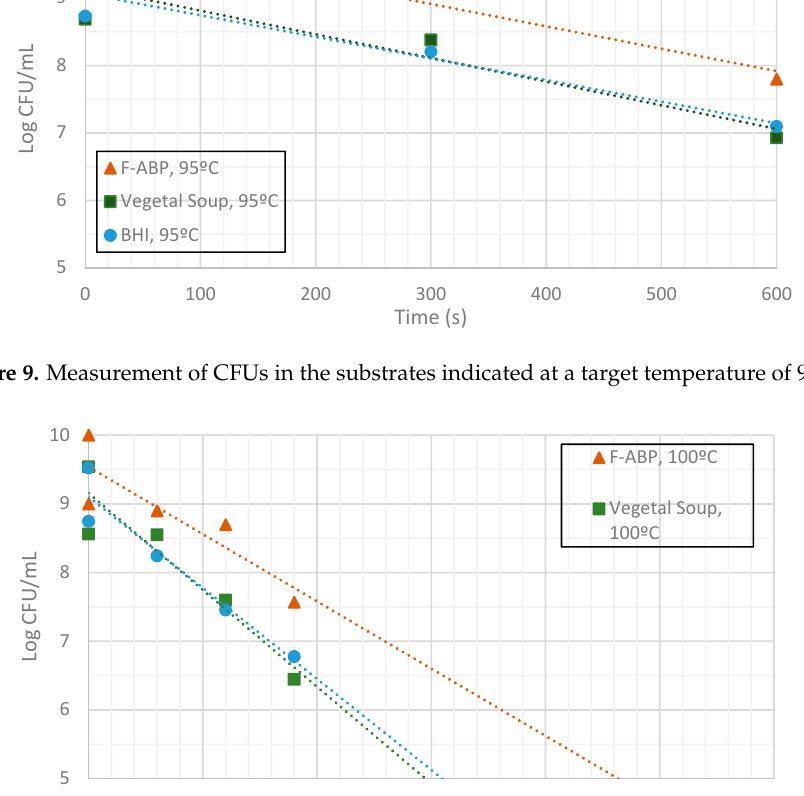
Figure 11. Measurement of CFUs in the substrates indicated at a target temperature of 105 °C. At 105 °C a fast inactivation is observed, with 3 log decimal reductions in less than 120 s in BHI, whereas to achieve the same inactivation in F-ABP more than 200 s are necessary, as Figure 11 shows. Vegetable soup required a time in between. Differences in heat inactivation can be explained by three main reasons: 